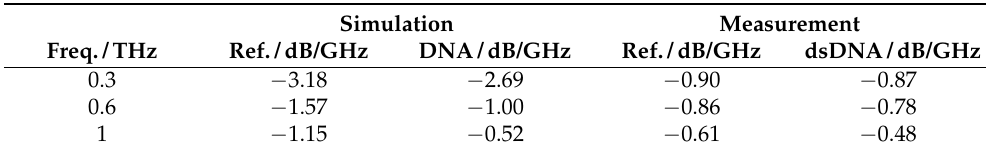
Table 2. Comparison of the maximum negative slope of the DRF for the simulation and measurement results for biosensors with resonance frequencies of 0.3THz, 0.6THz and